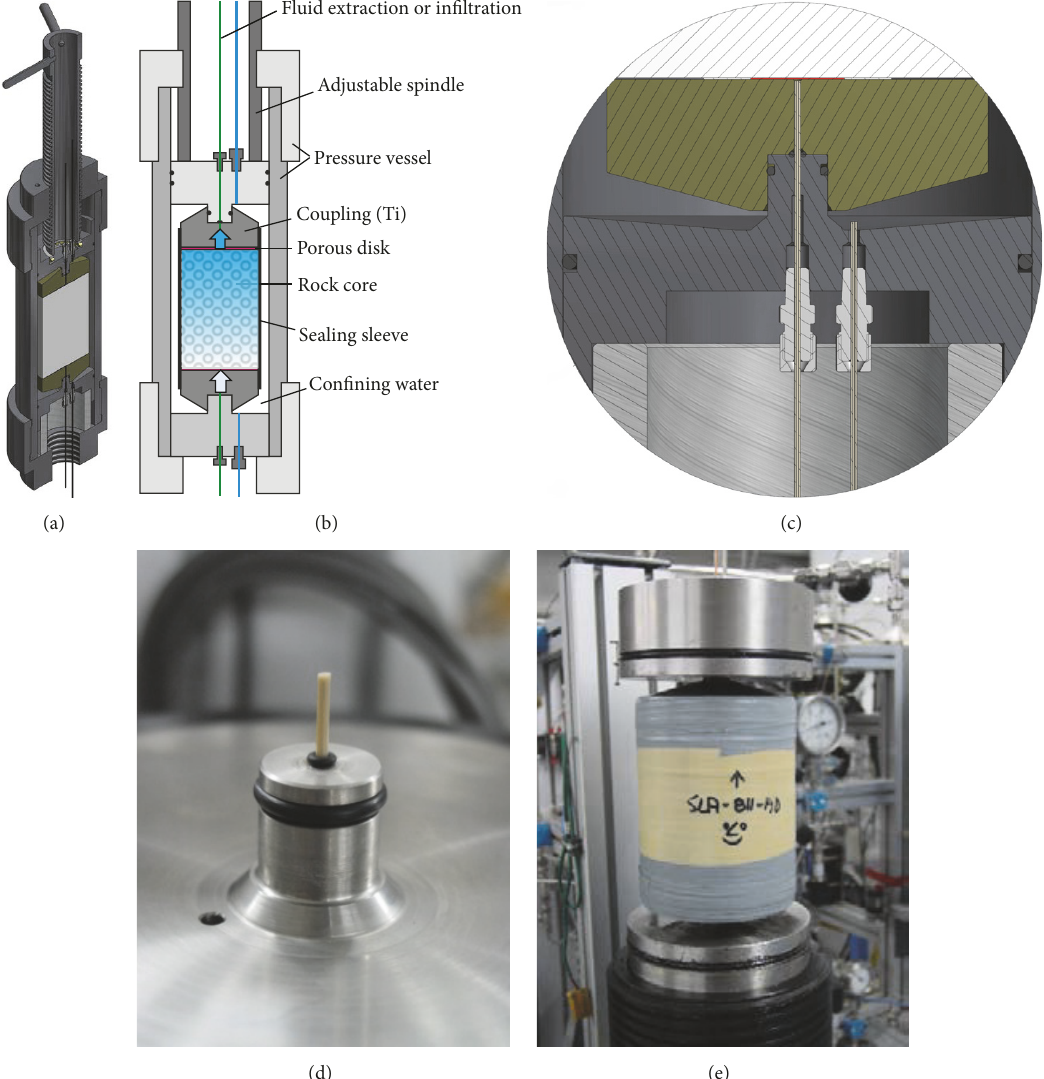
Figure 1: Advective displacement apparatus, (a) technical drawing, (b) schematic, (c) rock sample (white) with titanium coupling (green) and insert (dark grey) with details of O-ring seals and capillary for fluid injection (centre) and connection to confining fluid (off-centre), (d) insert with small O-ring sealing directly on the capillary for fluid injection, and (e) core sample mounted between inserts before lowering into pressure vessel. Inner diameter of this pressure vessel is 120 mm; the diameter of the sample core is